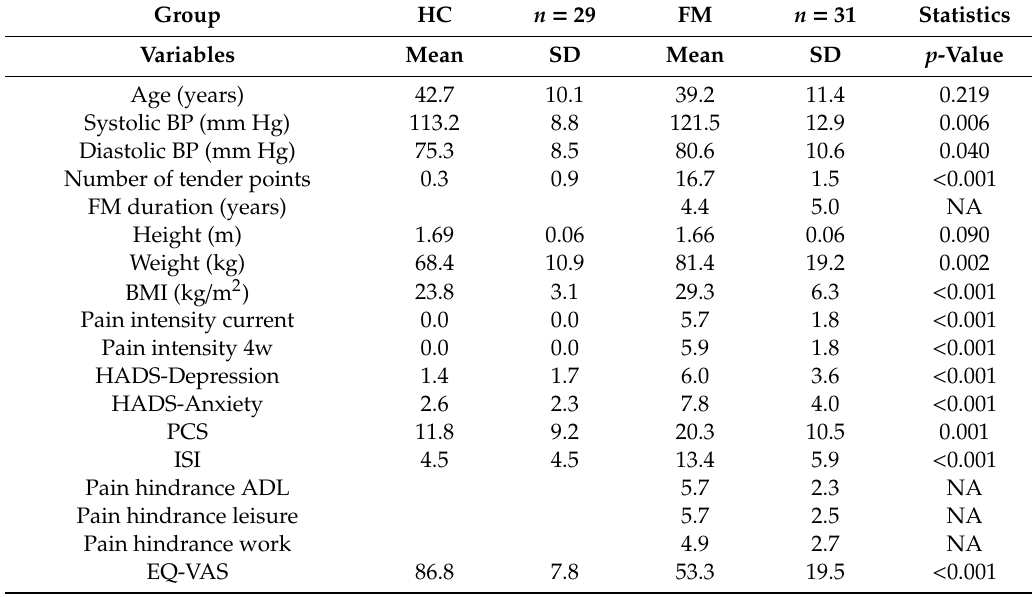
Table 1. Age, pain characteristics, psychological variables, the impact of pain and health aspects in the fibromyalgia group (FM) and in the healthy controls (HC); mean and one standard deviation (SD). Group HC n = 29 FM n = 31